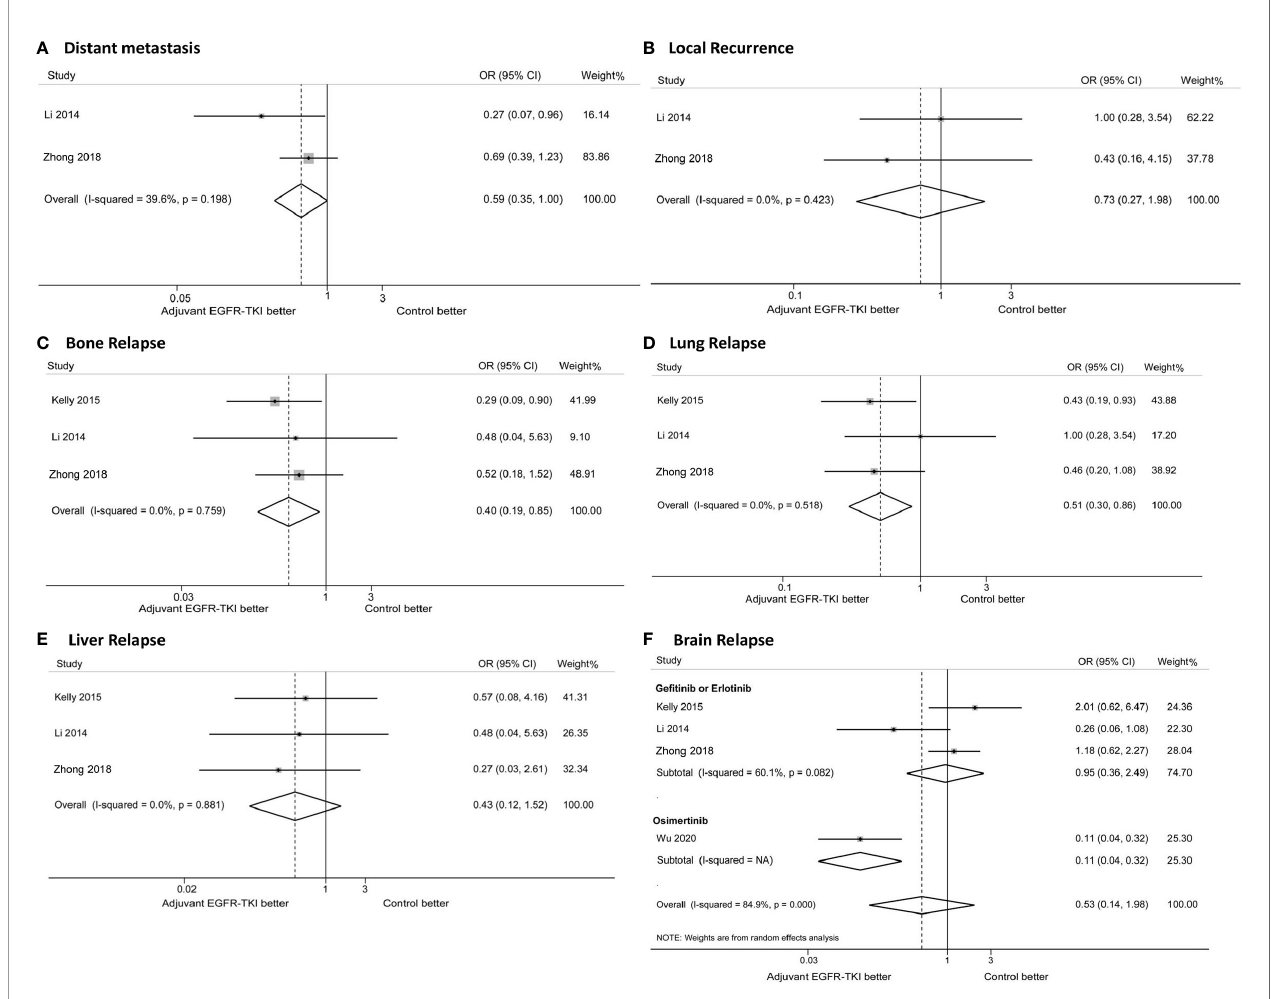
FIGURE 4 | Forest plots of odd ratios (ORs) for distant metastasis (A) , local recurrence (B) , bone relapse (C) , lung relapse (D) , brain relapse (D) , liver relapse (E) and brain relapse (F) . * Due to no event was reported, the study by Li was excluded in the analysis of liver relapse, and the study by Kelly was excluded in the analysis of distant metastasis and local recurrence.